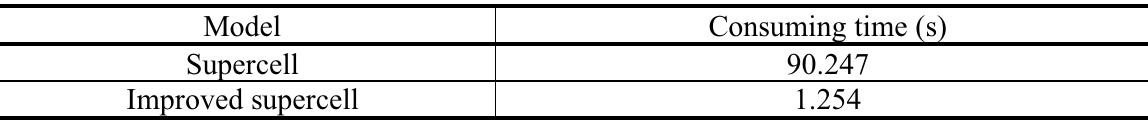
Table (cid:20)(cid:20) Comparison of efficiency between the two supercell